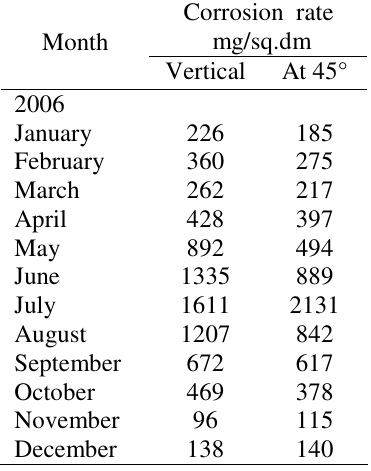
Table 3 . Positional effect on corrosion rate of mild steel